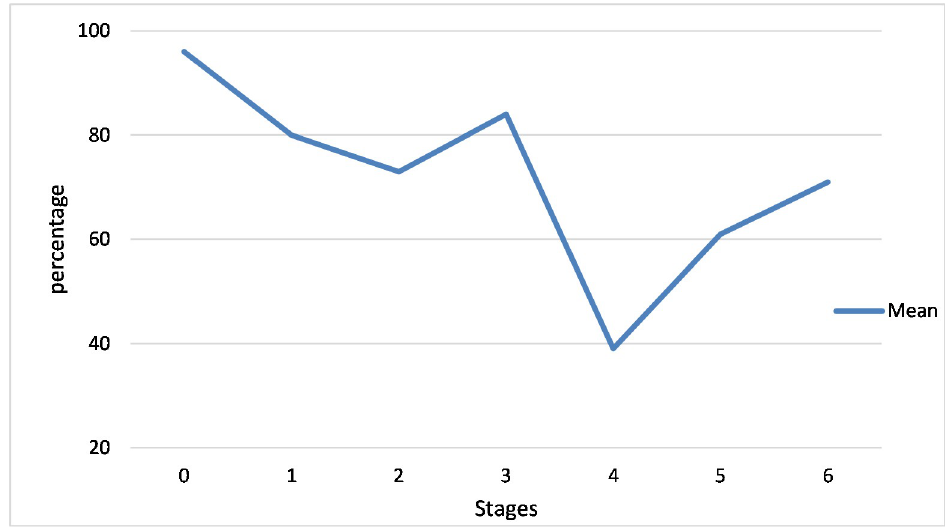
Fig 1. SoC percentile scores for total